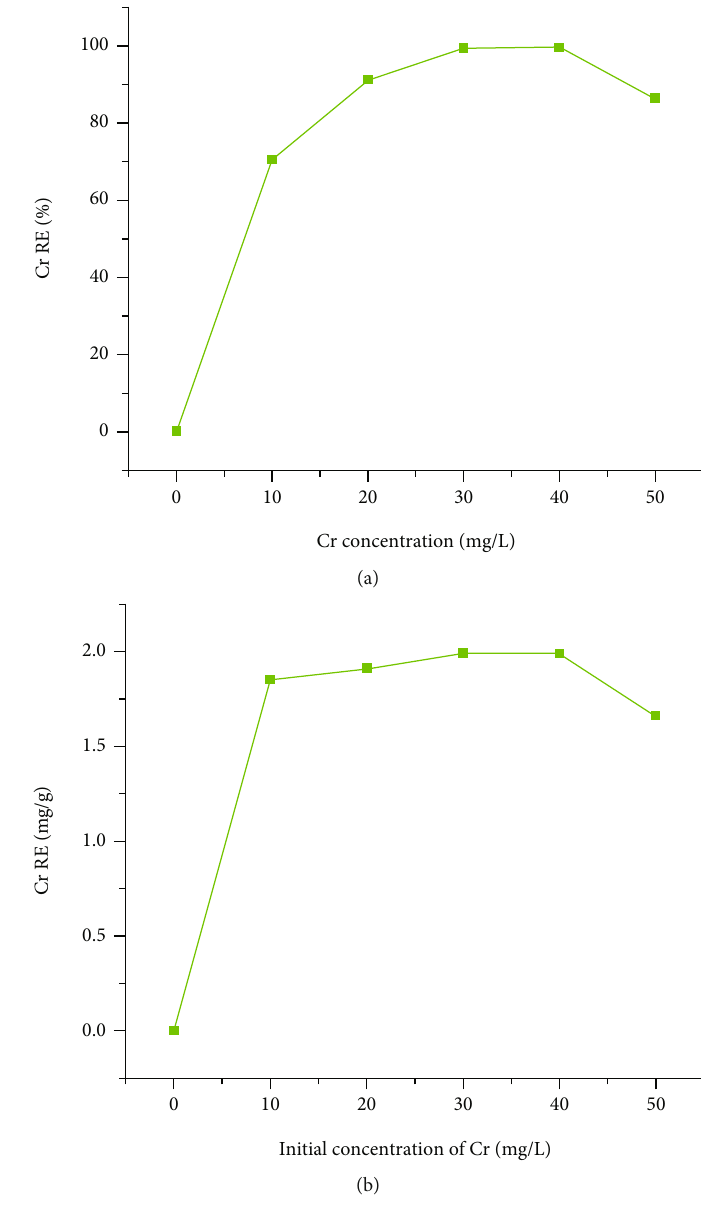
Figure 8: Initial Cr concentration e ff ects on (a) % RE and (b) mass adsorption e ffi ciency (mgg -1